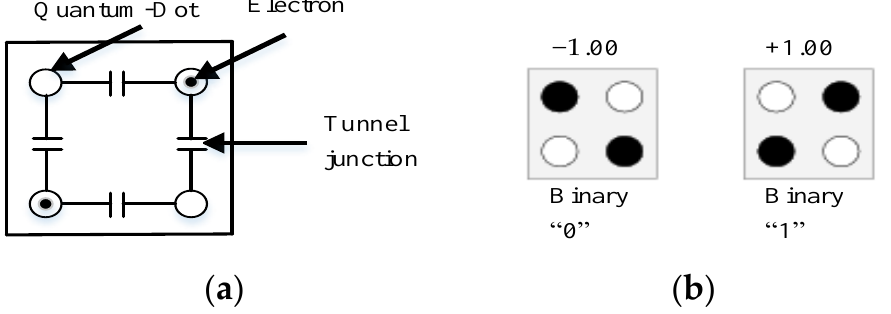
Figure 1. Schematics of QCA ( a ) cell, and ( b ) two structures logical values QCA cells. Four-phase clocks are also used as clocking in the QCA design to reduce the signal metastability and ensure the correct propagation of signals in the circuit [9] (Figure 2).